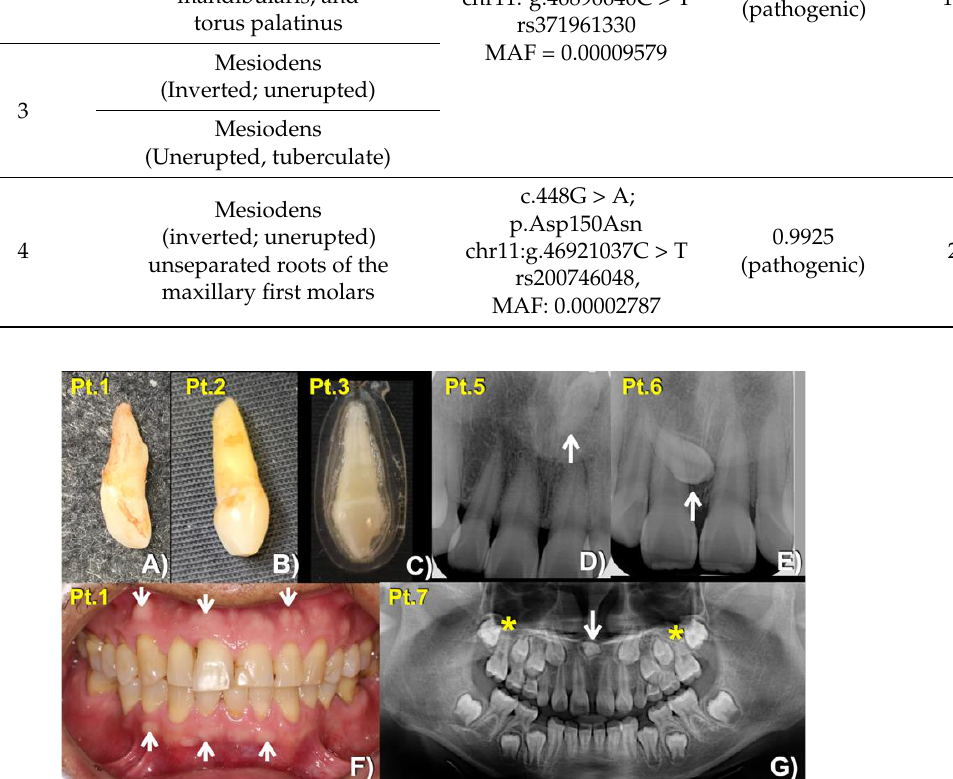
Figure 2. Mesiodens phenotypes. Extracted mesiodens of ( A ) patient 1, ( B ) patient 2. ( C ) patient 3. ( D , E ) Periapical radiographs show ( D ) Patient 5 — Inverted mesiodens (arrow). ( E ) Patient 6 — Unerupted mesiodens (arrow). ( F ) Patient 1 — Buccal exostoses (arrows). ( G ) Panoramic radiograph showing inverted mesiodens (arrow) and unseparated roots of the maxillary first permanent molars (asterisks).